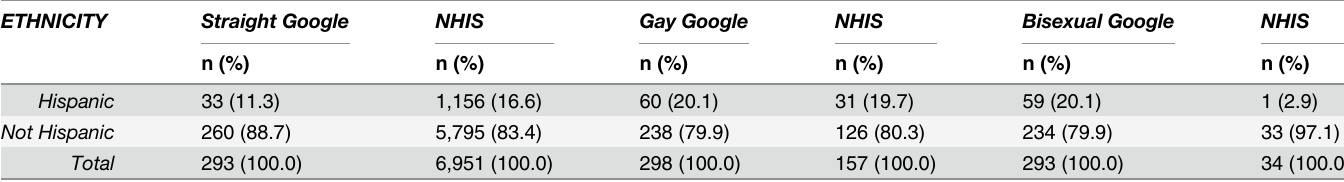
Table 4. Google Android Panel Samples and the NHIS Reported Ethnicity for Men by Sexual Orientation. ETHNICITY